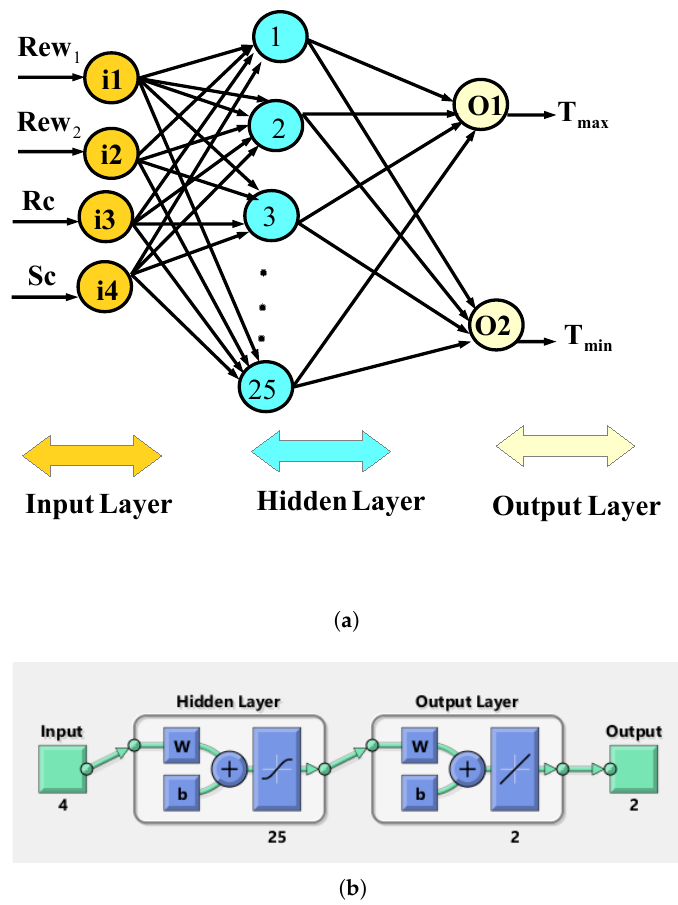
Figure 11. Schematic of the ANN with inputs–outputs ( a ) and network architecture with different layers ( b